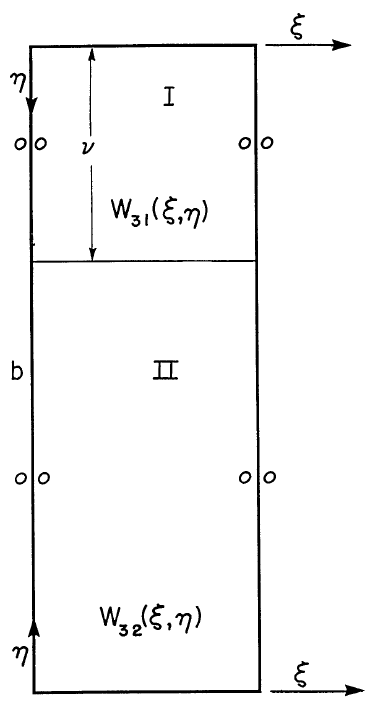
Fig. 3. Schematic representation of intermediate building block uti- lized in order to arrive at solution for third building block of Fig. 2. edges. This building block is driven by a harmonic force distributed along a line dimensionless distance ‘ u ’ from the η axis. The distributed amplitude of this driving force will be expressed in series